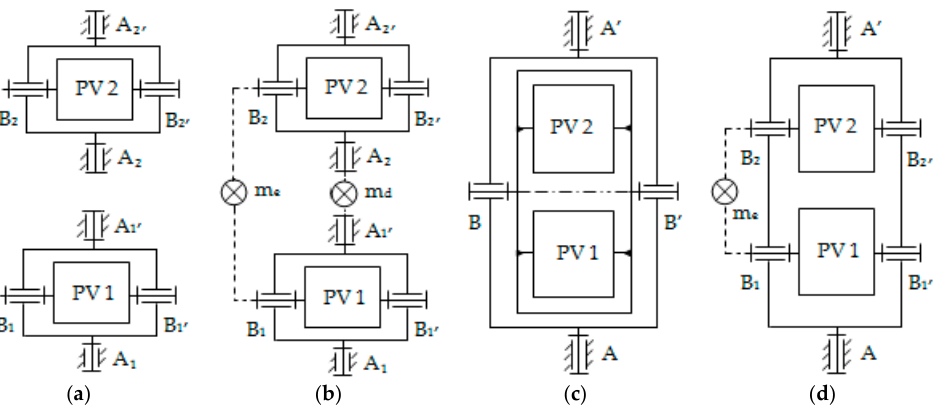
Figure 1. Solar trackers configurations: ( a ) Individual modules; ( b ) String; ( c ) Platform; ( d ) String platform.